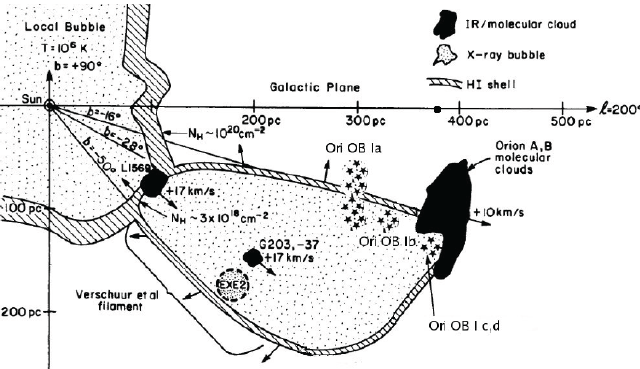
Figure 7. The Orion region is characterised by two massive molecular clouds at about 450 pc distance, with recent massive-star formation preferentially on its near side (star symbols), and a large cavity bounded by denser HI emission, which extends from the clouds towards the direction of the Sun. ( [Updated from 37] [by